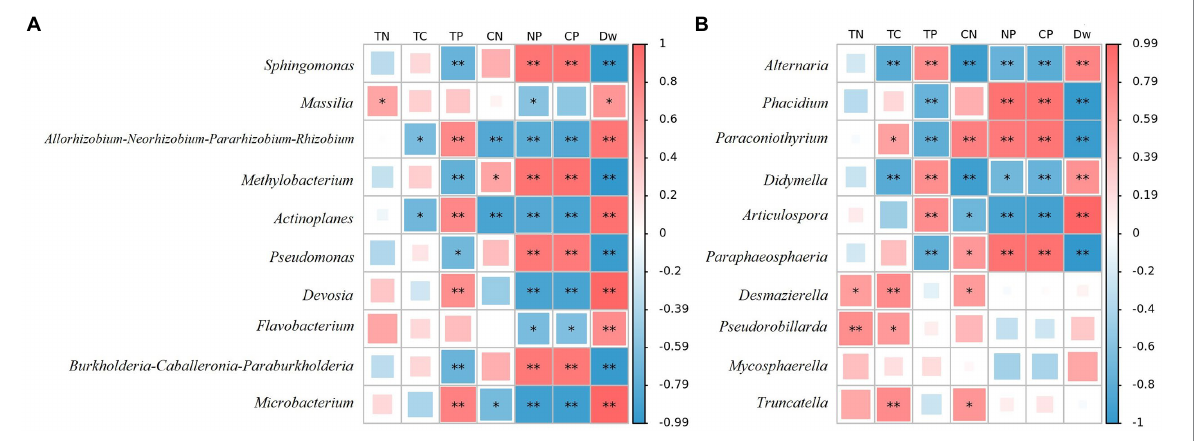
FIGURE 5 CoHeatmap shows the 10 genera relative abundance and chemical composition in various samples of litter. (A) Bacteria; (B) Fungi. The legend shows the correlation coefficient values, with red representing positive correlations and blue representing negative correlations. Shades of color indicate the strength of the correlation. * represents p < 0.05; ** represents p < 0.01. TN: Total N; TC: Total C; TP: Total P; CN: C/N; NP: N/P; CP: